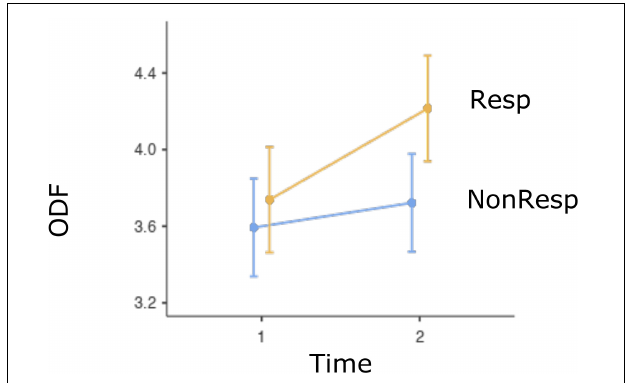
FIGURE 1 | Fixed effect plot with 95% CI for the evolution of ODF for responders and non-responders. Note. ODF, overall defensive functioning; Resp, responders; Non-Resp, non-responders; Time 1, pretherapy; Time 2, posttherapy.